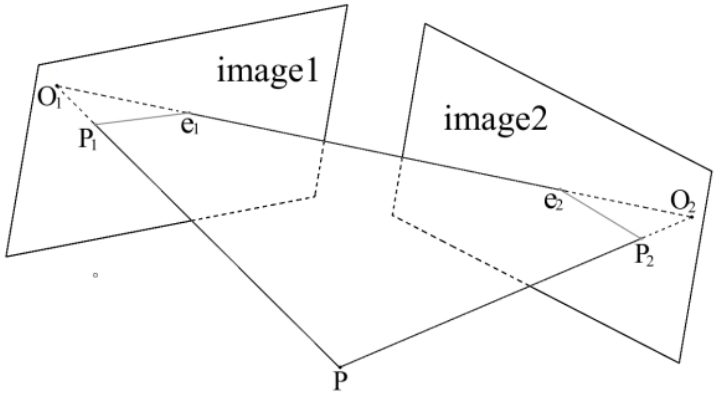
Figure 9. Geometric model of the epipolar constraint.